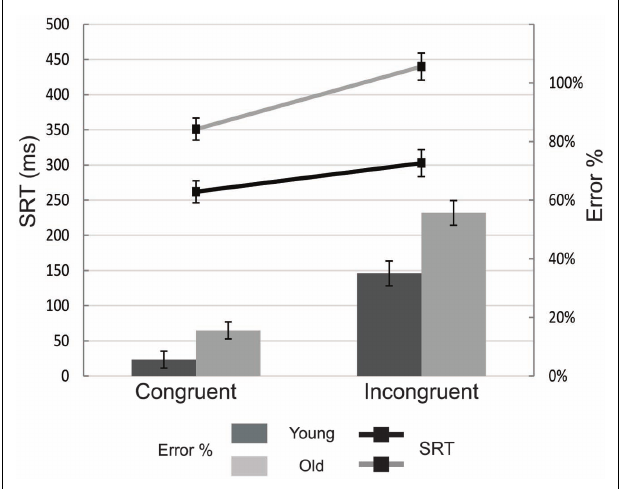
FIGURE 2 | Mean saccade reaction times (SRT; line graph) and error rates (bar graph) for each of the experimental conditions. Young subjects are depicted with black lines and dark-gray bars. Old subjects are depicted with light gray lines and bars. Error bars represent the